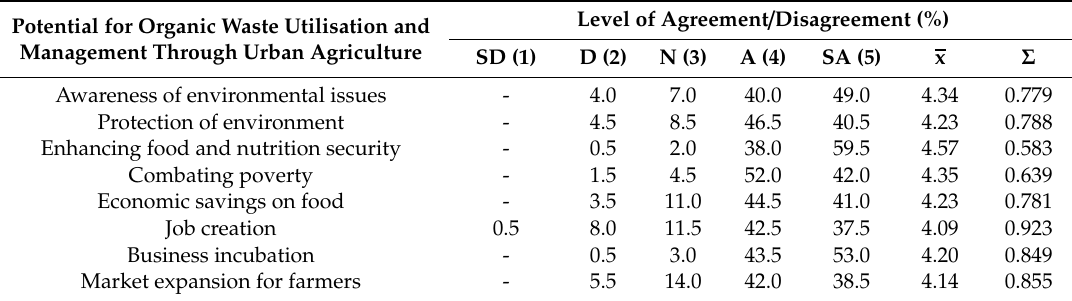
Table 8. Opportunities for utilising organic waste through urban agriculture in the Durban South Basin (n = 200).